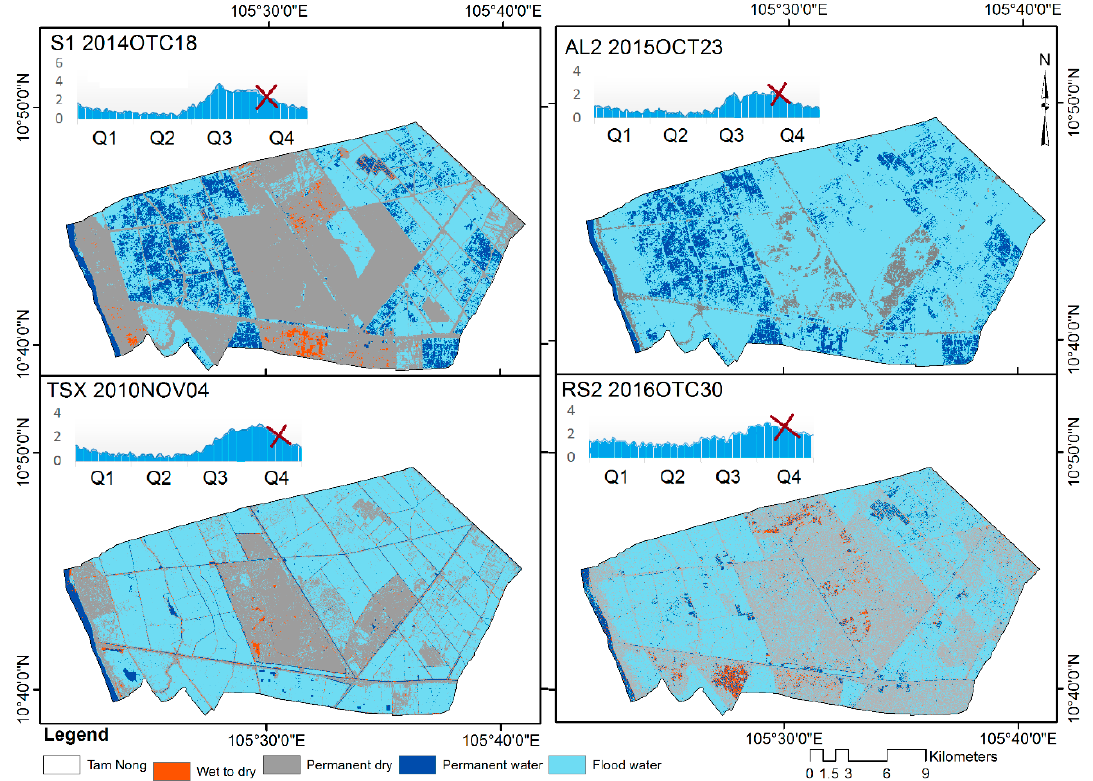
Figure 13. SAR remote sensing-based inundation maps. Flooded areas are shown in light blue, permanent water (i.e., appearing in both flooded and dry season) is shown in dark blue, and the orange pixels represent areas which turned from wet in the dry season to dry in the flooding season. Q stands for the year quarter.